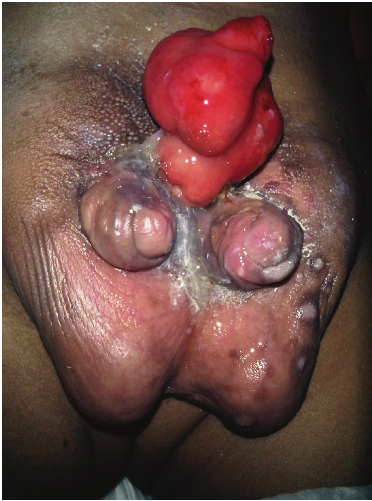
Figure 1: Complete and separate diphallia. Over the region of the pubis, a bowel loop-like structure was seen.